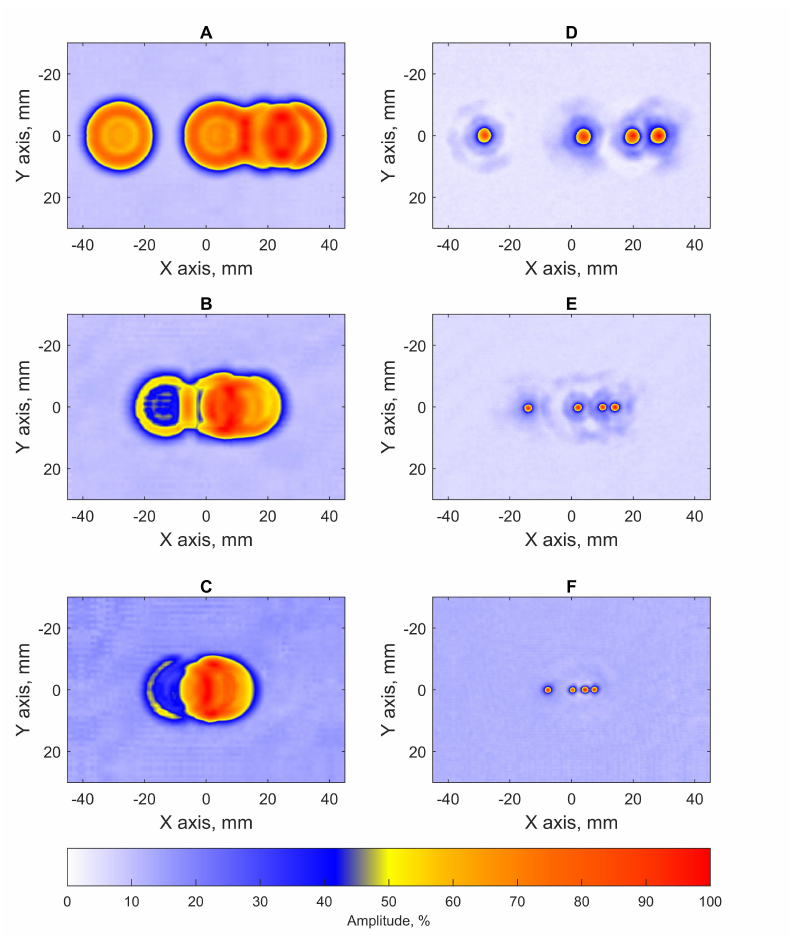
Figure 11. C-scans of samples with close-spaced defect: ( A ) C-scan of sample D without PR-FZP application, ( B ) C-scan of sample E without PR-FZP application; ( C ) C-scan of sample F without PR-FZP application; ( D ) C-scan of sample D with PR-FZP application; ( E ) C-scan of sample E with PR-FZP application; ( F ) C-scan of sample F with PR-FZP application.